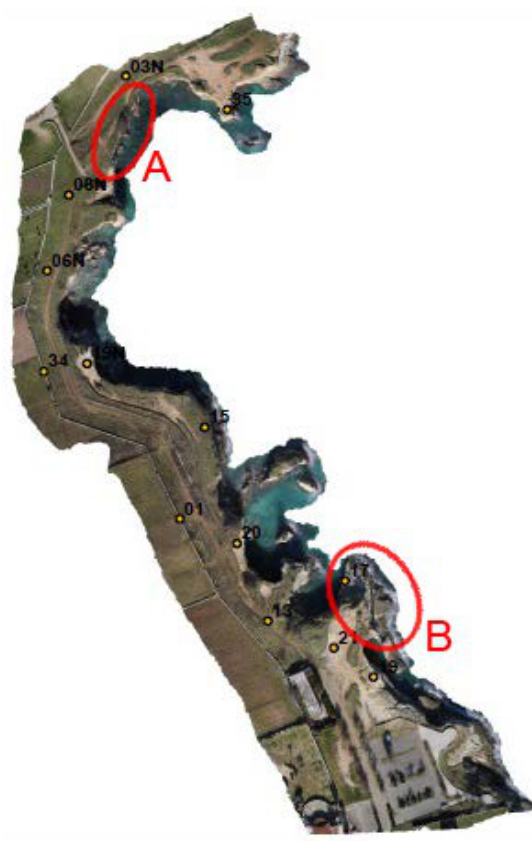
Figure 3. Orthophoto of the surveyed area with GPC location